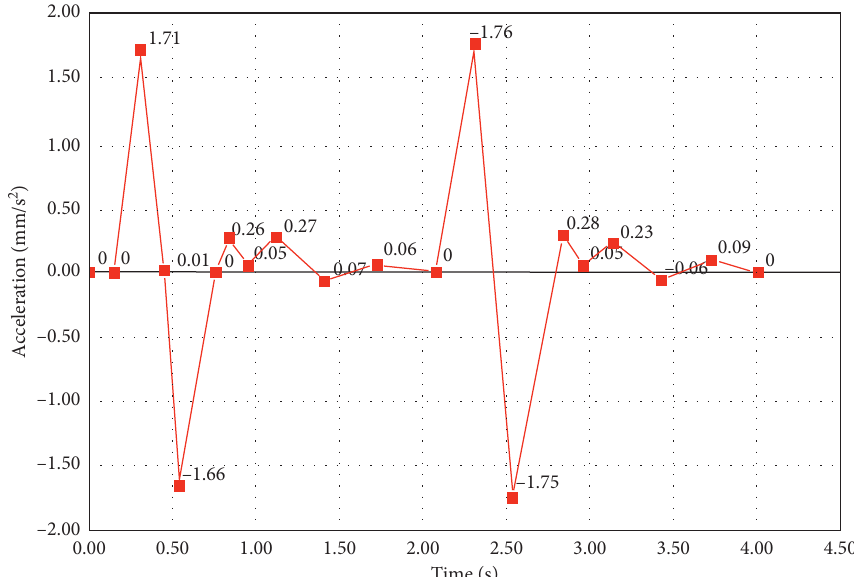
Figure 35: Measured ground acceleration at the pit bottom.